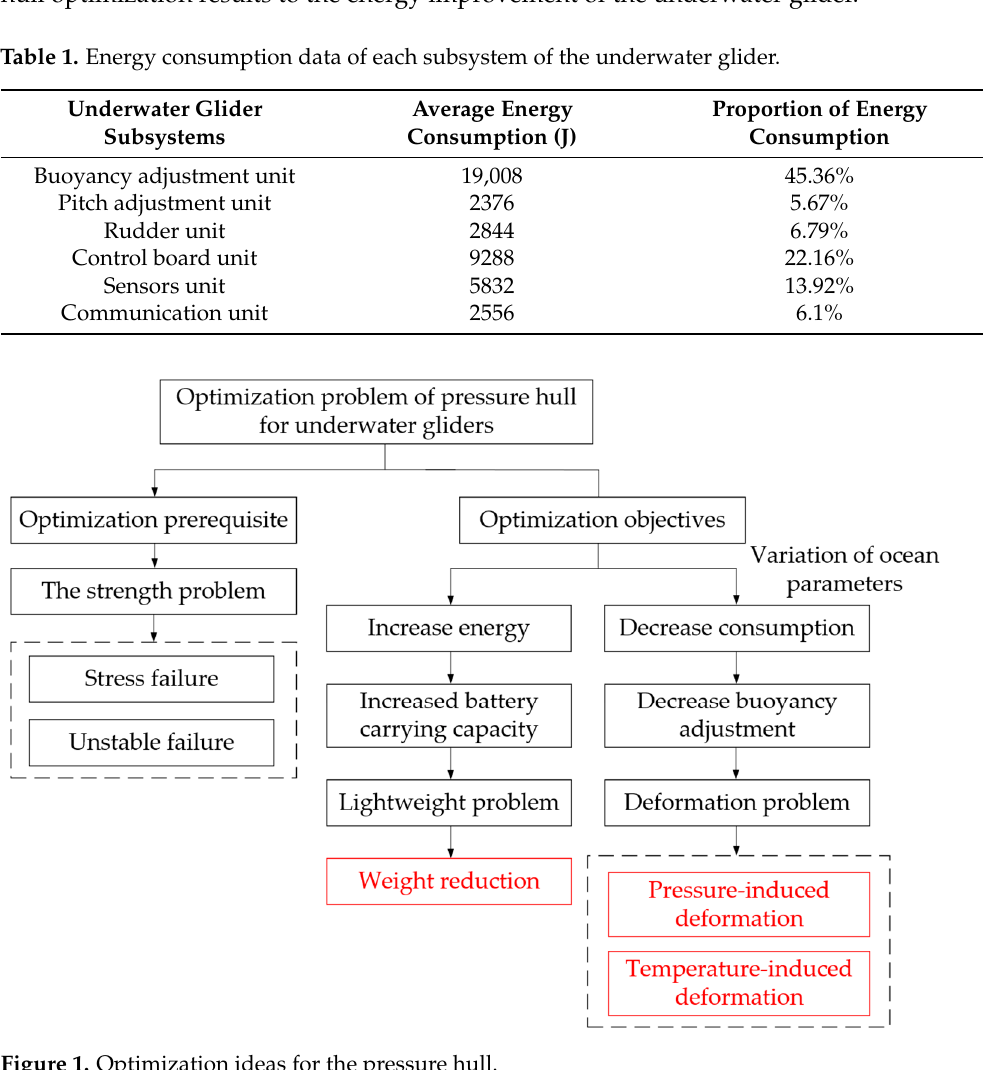
Figure 1. Optimization ideas for the pressure